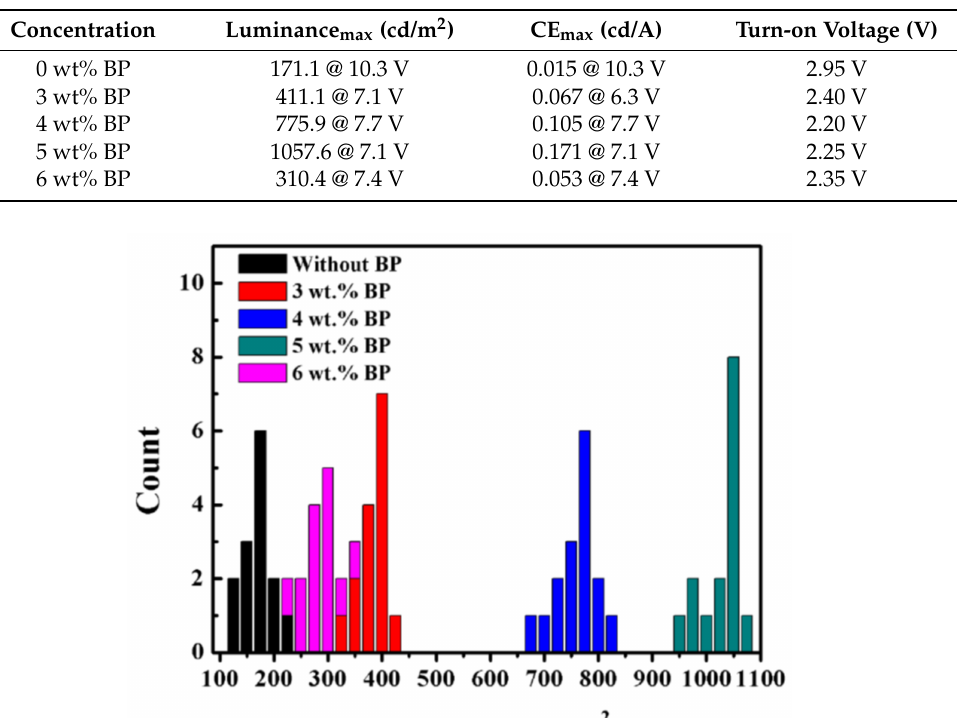
Figure 6. Performance distribution of PeLEDs with each BP concentration.